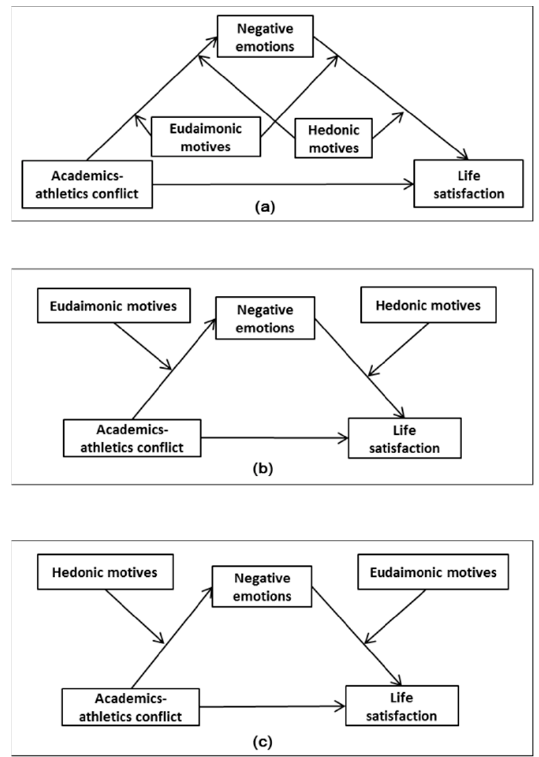
Figure 1. Theoretical model of moderated mediating effect. Subfigure ( a ), ( b ) and ( c ) showed the model proposed in hypothesis 3 (a), 3(b) and 3(c), respectively.